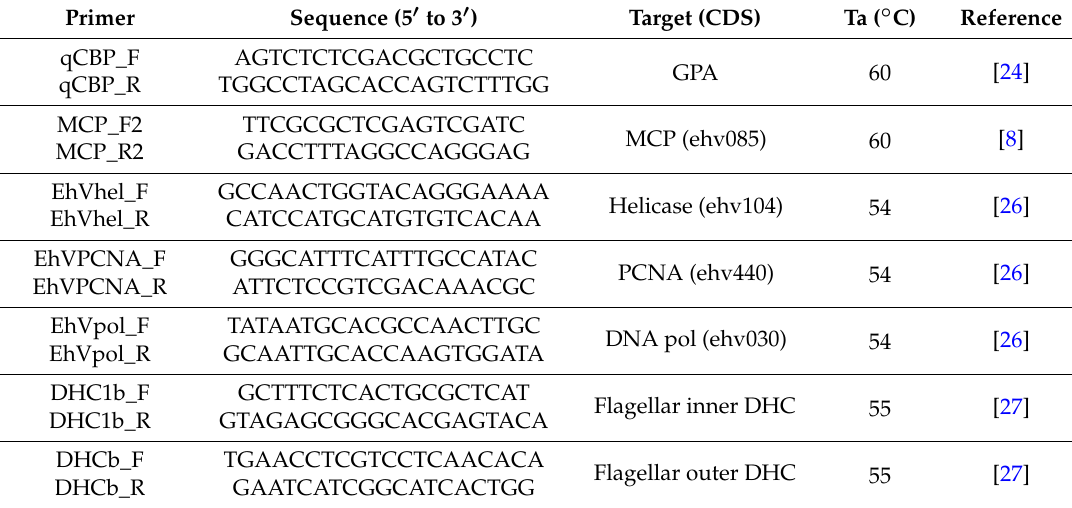
Table 2. Primers used in this